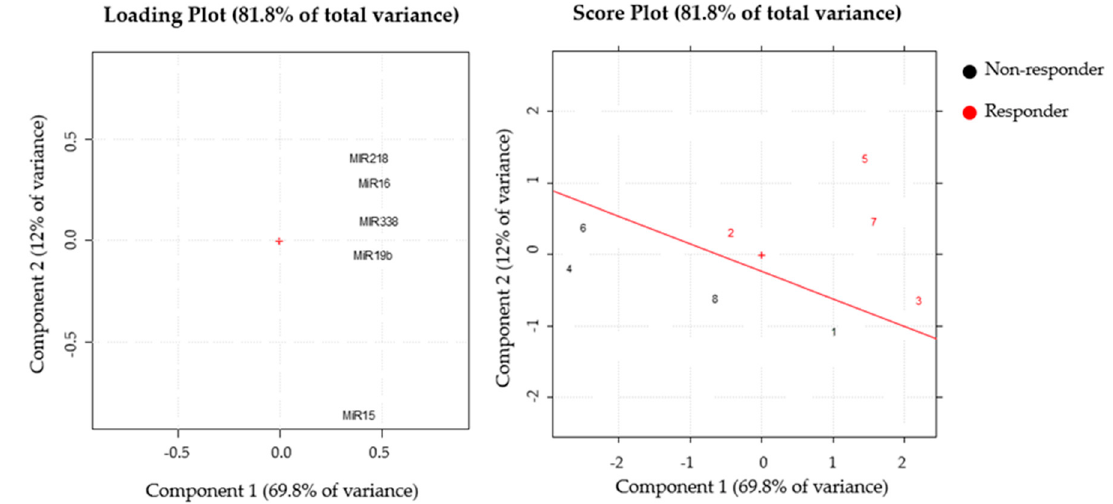
Figure 5. PCA performed on responder and non-responder patients’ samples. The loading (left panel) and the score plot (right panel) were reported. In the score plot, the samples were indicated by the number reported in Table 3. + represents the point with coordinates 0 and 0 for x and y axes, respectively. This points is the reference to define the multivariate space.